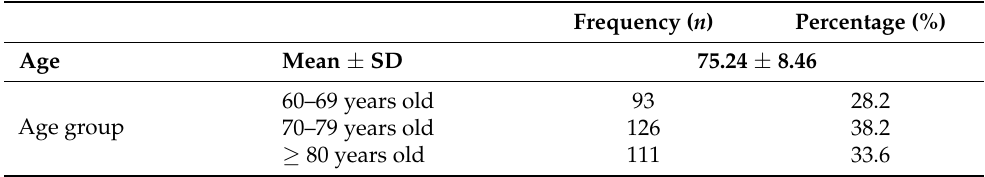
Table 2. Study population characteristics ( n =